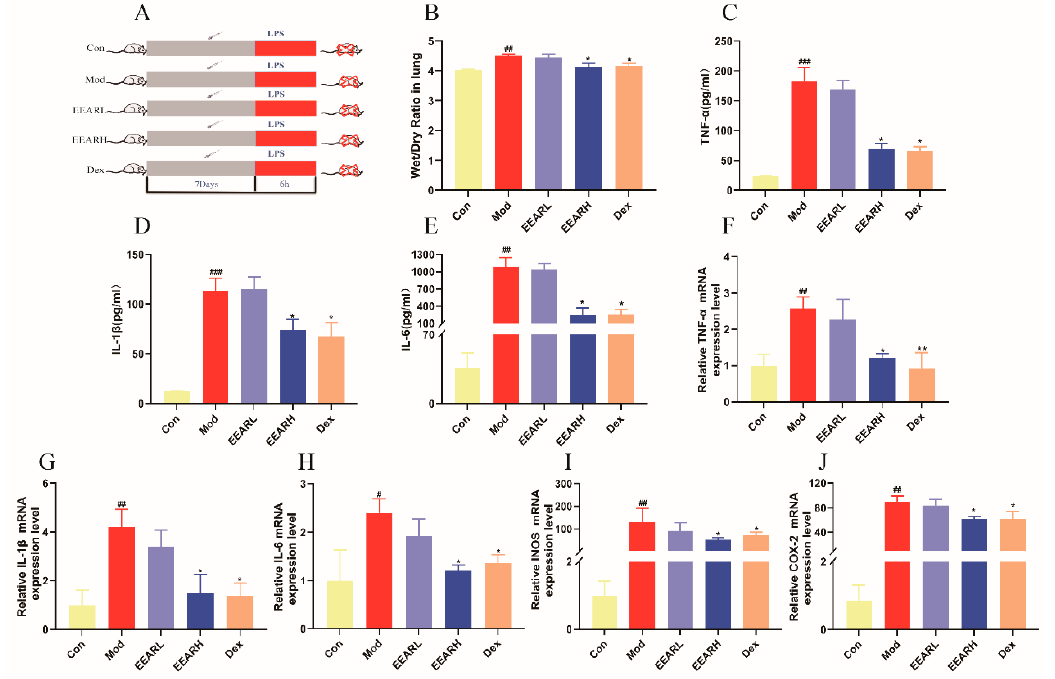
Figure 2. EEAR alleviated lung inflammation and reduced the wet-dry ratio in rats with ALI. ( A ) Experimental flowchart. ( B ) Lung W / D ratio determined 6 h after LPS challenge ( n = 10). The levels of ( C ) TNF- α , ( D ) IL-10, and ( E ) IL-6 in BAFL were determined by ELISA ( n = 10). The relative expression of ( F ) TNF- α , ( G ) IL-1 β , ( H ) IL-6, ( I ) INOS, and ( J ) COX-2 in rat lung tissue were evaluated by RT-qPCR ( n = 6). Values are expressed in means ± SEM. ### p < 0.001 vs. Control; ## p < 0.01 vs. Control; # p < 0.05 vs. Control; ** p < 0.01 vs. Model; * p < 0.05 vs. Model.